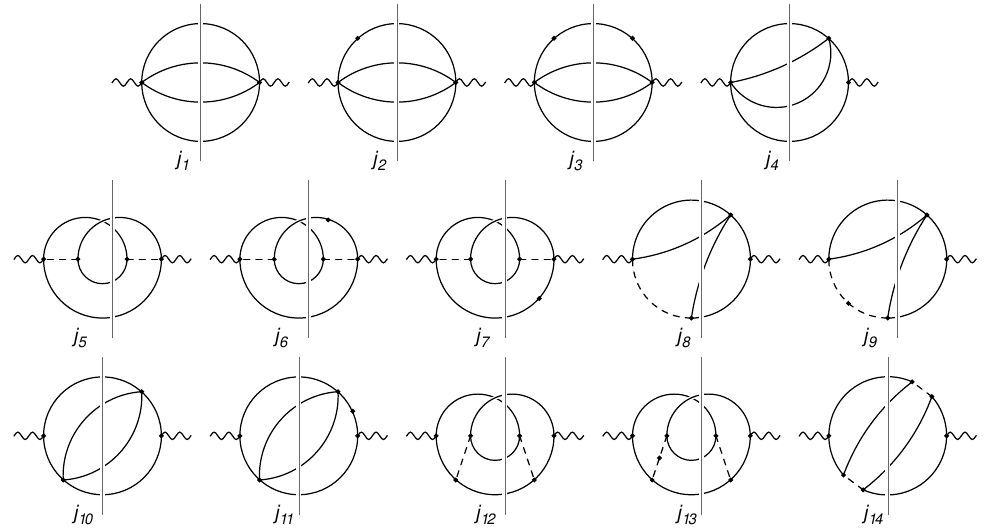
Figure 2 . Photon polarization diagrams with non-zero 4 m cuts contributing to total cross-section of e + e (cid:0) annihilation into two heavy quark anti-quark pairs.